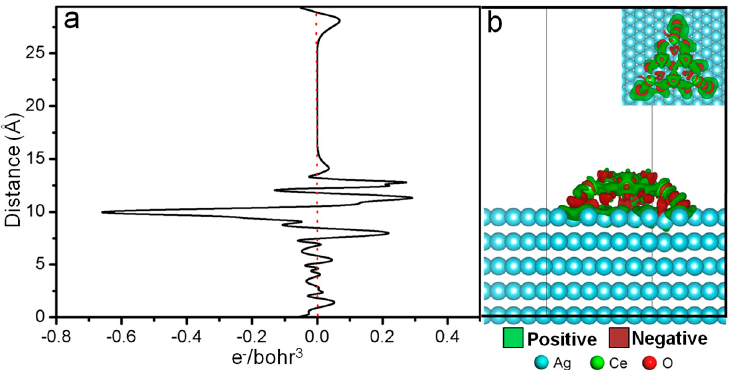
Figure 2. Electron density difference (EDD) of the CeO x /Ag(111). ( a ) Electron density difference (EDD) versus Z direction of the CeO x /Ag(111) catalyst, ( b ) Isosurfaces for EDD distribution. Table 1. Bader charge of the Ce and Ag atoms under the CeO x cluster of CeO x /Ag(111).